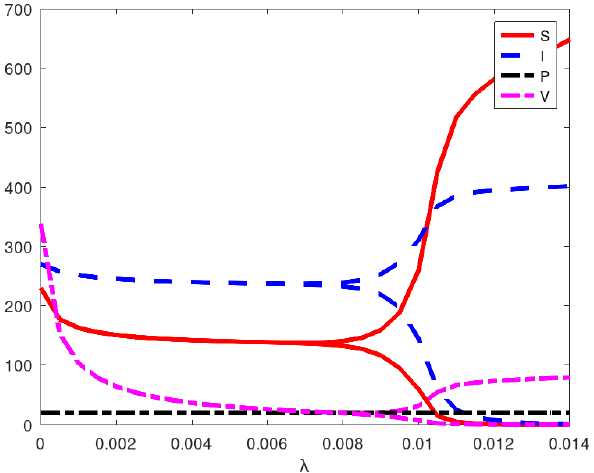
Figure 9. Hopf bifurcation diagram in terms of the parameter λ . Above the critical threshold λ † ≈ 0.008, the stable coexistence equilibrium (cid:98) E ∗ loses its stability, and the cycles are triggered. The two curves in the right portion of the diagram denote the peaks and the troughs of the oscillations. The other parameters are given in (23) and (28) with the initial conditions (22) and (27). As expected, higher values of pathogen pickup from the environment significantly reduce both the free viral load and slightly the level of the susceptible prey, in the range λ ∈ [ 0, 0.002 ] . Past the critical threshold λ † ≈ 0.008, population oscillations are triggered, leading to high disease prevalence due to increasing numbers of infected and susceptible that alternate between very high and very low values. Predators are essentially not affected by these dynamics, as they typically settle near their carrying